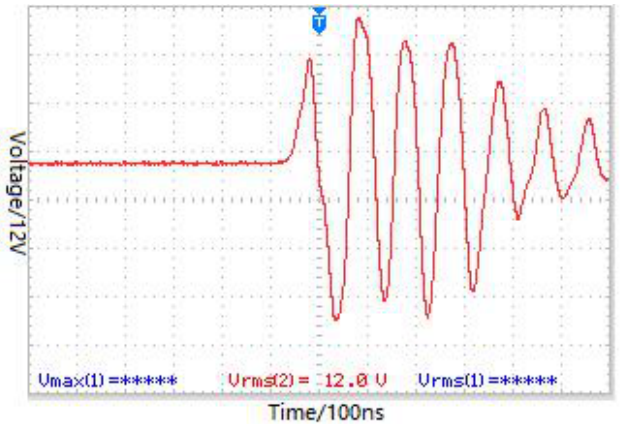
Figure 7. Thyristor 3 grid interference signal.